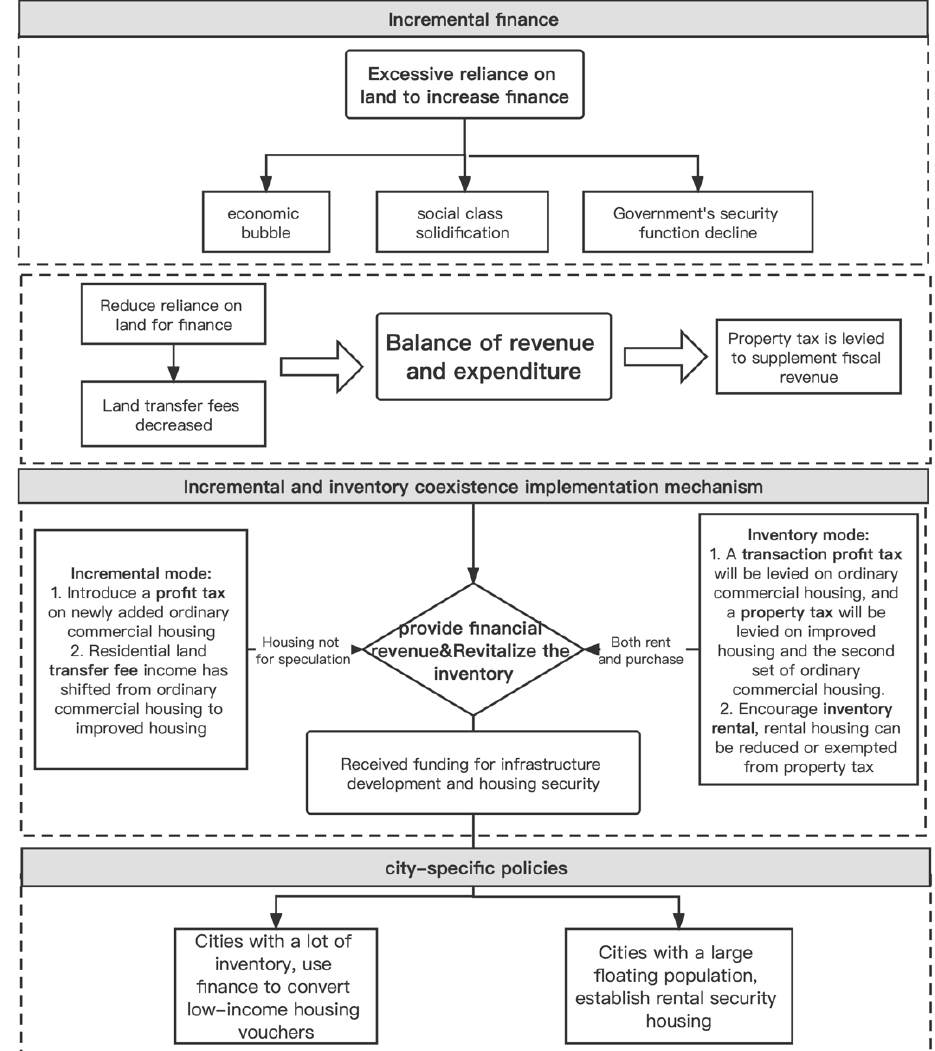
Figure 2. Diagram of the local land-finance transformation mechanism with synergy between increment and inventory.